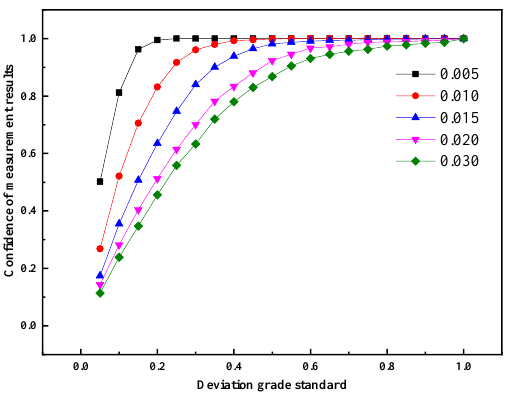
Figure 9. Relationship between deviation grade standard and confidence of measurement results under the different relative standard deviations of temperature at mean temperature 543 K.